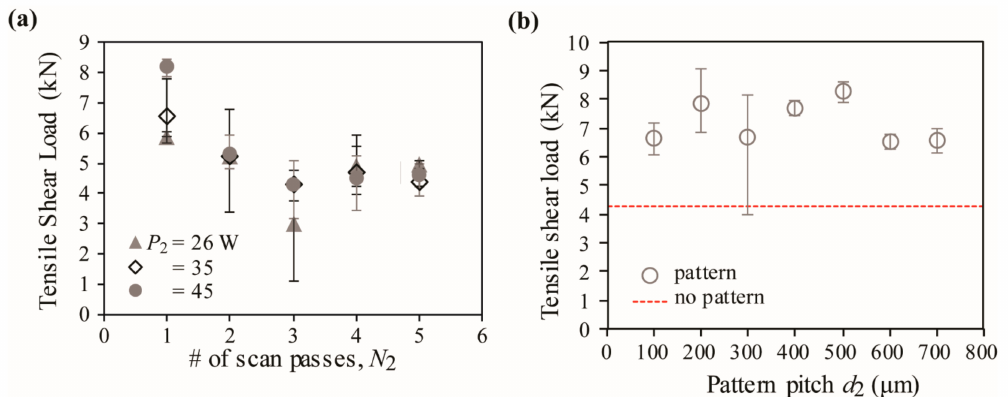
Figure 5. ( a ) Pattern depth variation and ( b ) hump height variation w.r.t. the number of scan passes N 2 under di ff erent nanosecond laser powers P 2 = 26 W, 35 W, and 45 W. A laser scan speed of v 2 = 200 mm / s and focal length of z 2 = 0 mm were used.